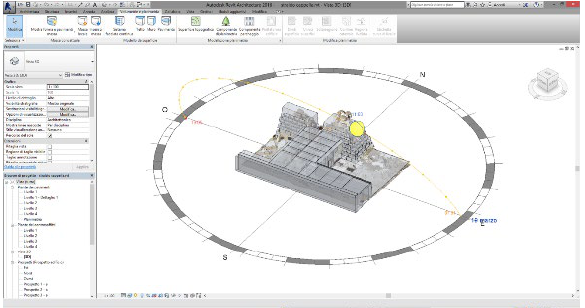
Figure 10: The positioning of the sun visualized thanks to the environmental system.